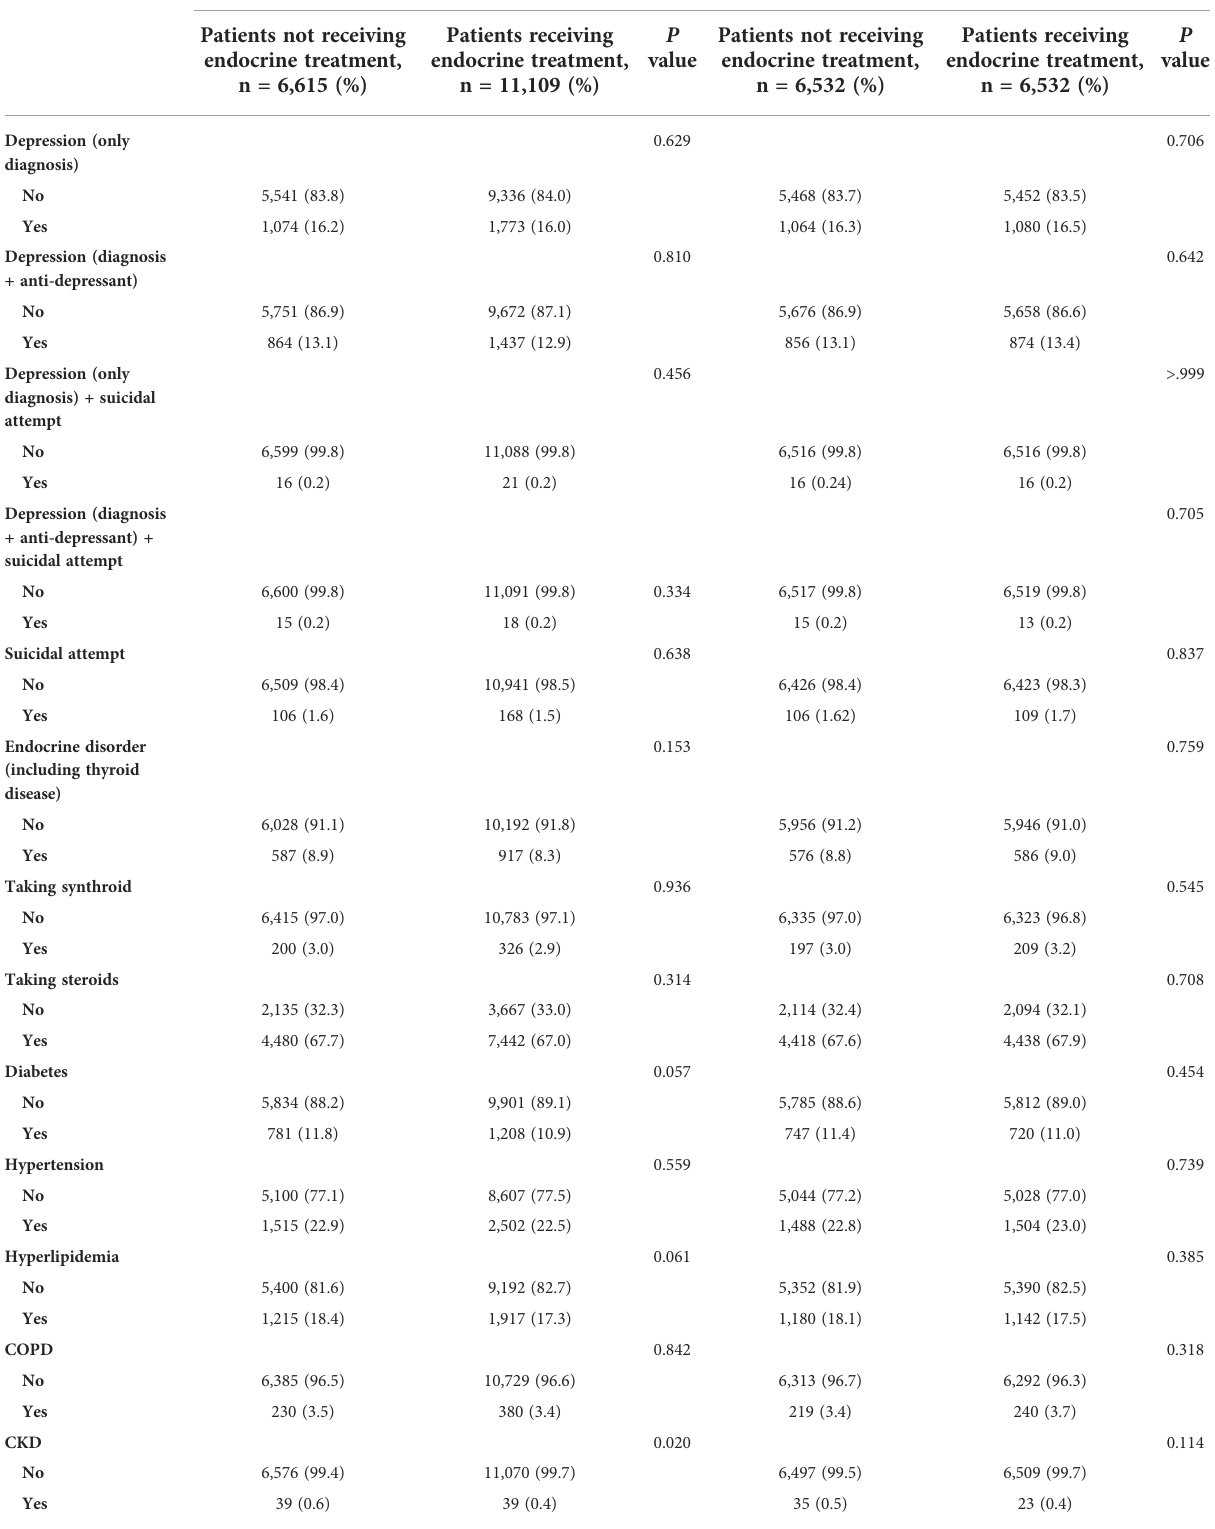
TABLE 1 Comparison of clinical characteristics of patients with breast cancer and DCIS according to receipt of endocrine treatment. Before matching After matching P P Patients not receiving Patients receiving Patients not receiving Patients receiving endocrine treatment, endocrine treatment, value endocrine treatment, endocrine treatment, value n = 6,615 (%) n = 11,109 (%) n = 6,532 (%) n = 6,532 (%) Depression (only diagnosis)